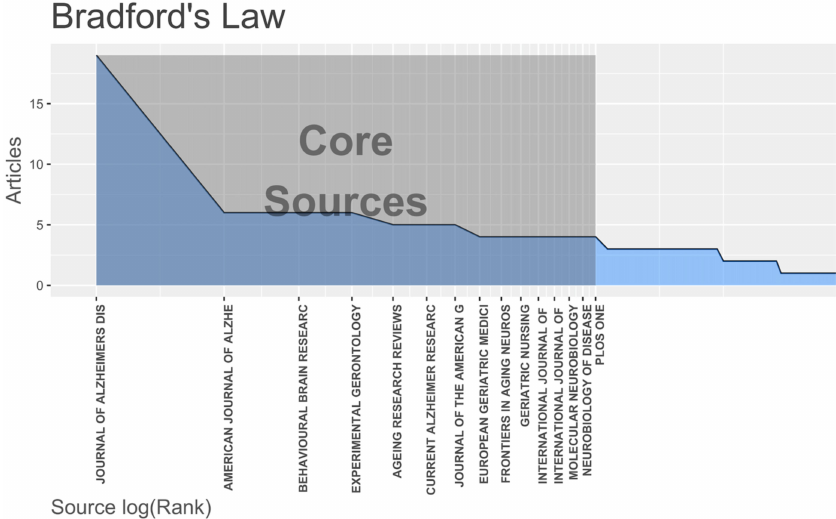
Figure 4. The core journals in the AD exercise research field based on Bradford’s